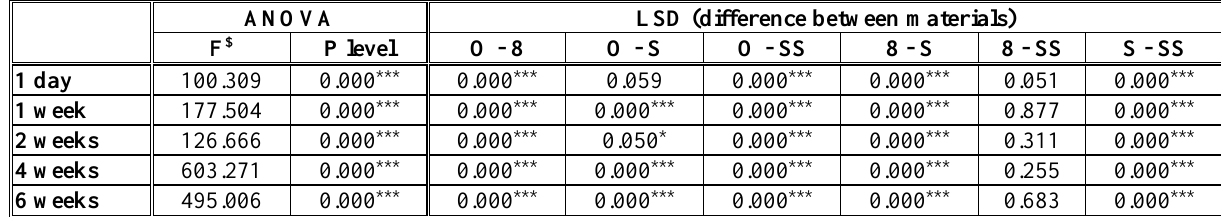
Table 4: Difference between the degree of rotation according to the ligation method at the five time intervals by ANOVA and LSD